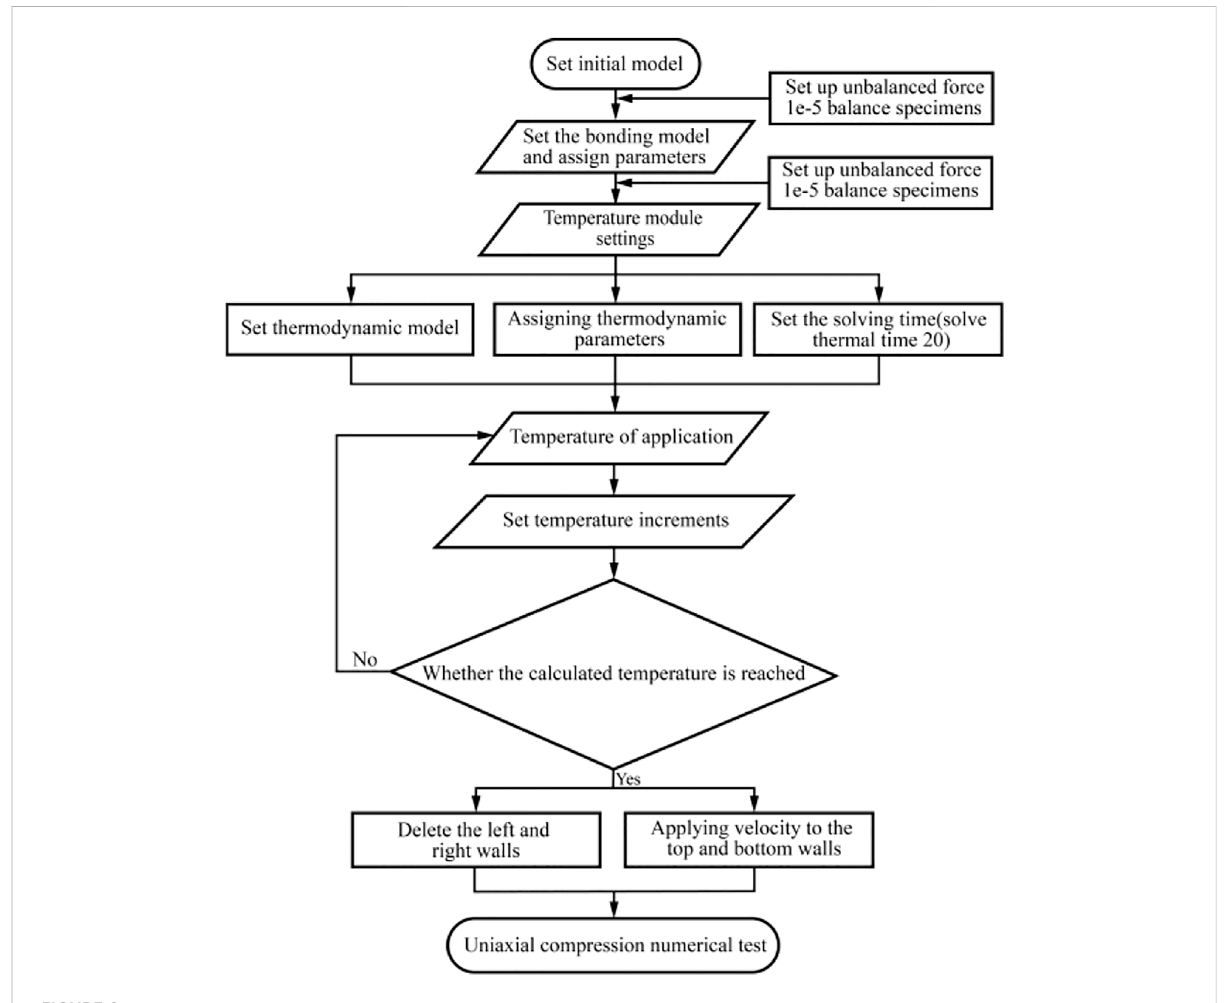
FIGURE 2 Numerical calculation